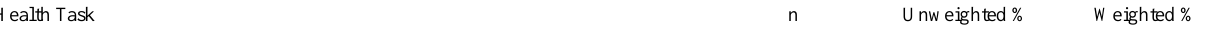
Table 2. Weighted and unweighted unadjusted prevalence estimates for eHealth tasks, Health Information National Trends Survey (HINTS) 4 Cycle 1, October 2011 to February 2012 (2012) (N=2358). Ever looked for information about health or medical topics from any source?